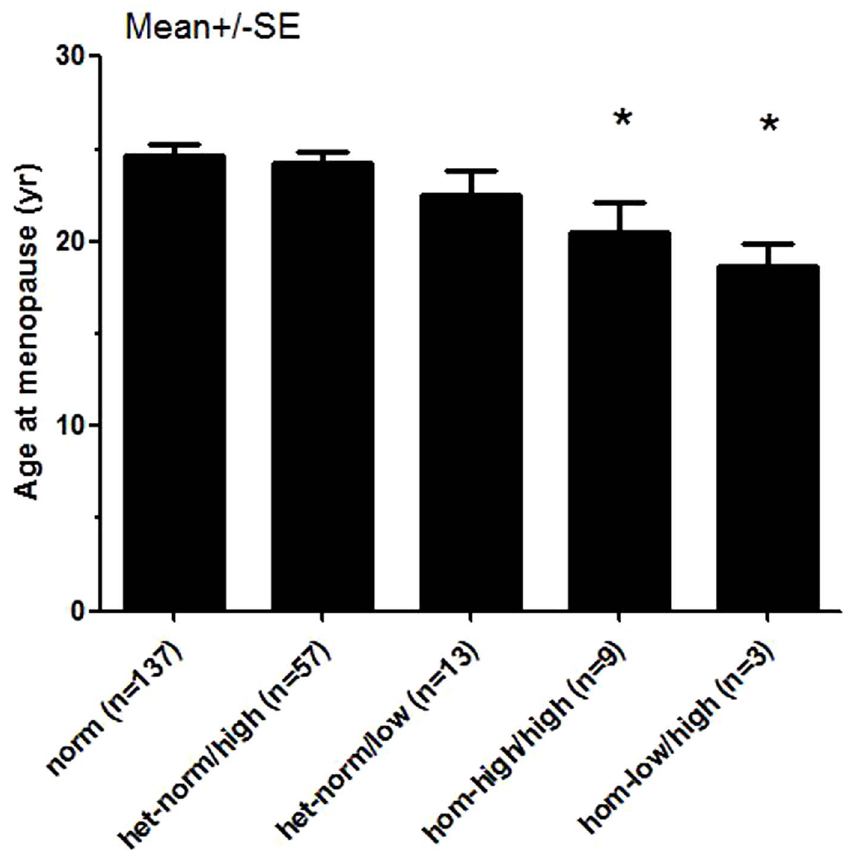
Figure 1. POF patients with sub-genotype hom-high/highandhom-low/high showed earlier age at menopause compared with norm (20.4 ± 4.8 vs. 24.7 ± 6.4, p , 0.01; 18.7 ± 1.7 vs. 24.7 ± 6.4, p , 0.01, respectively). doi:10.1371/journal.pone.0103316.g001 PLOS ONE |